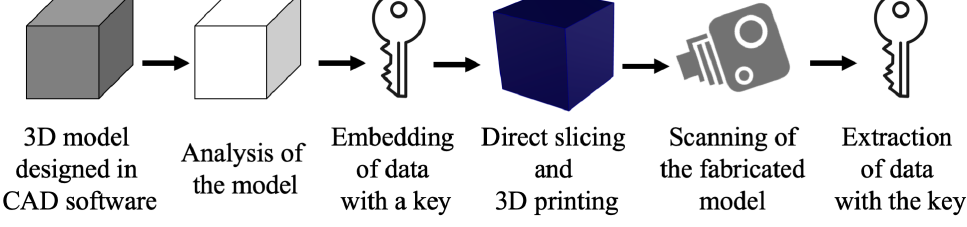
Figure 5. Design and manufacturing pipeline for